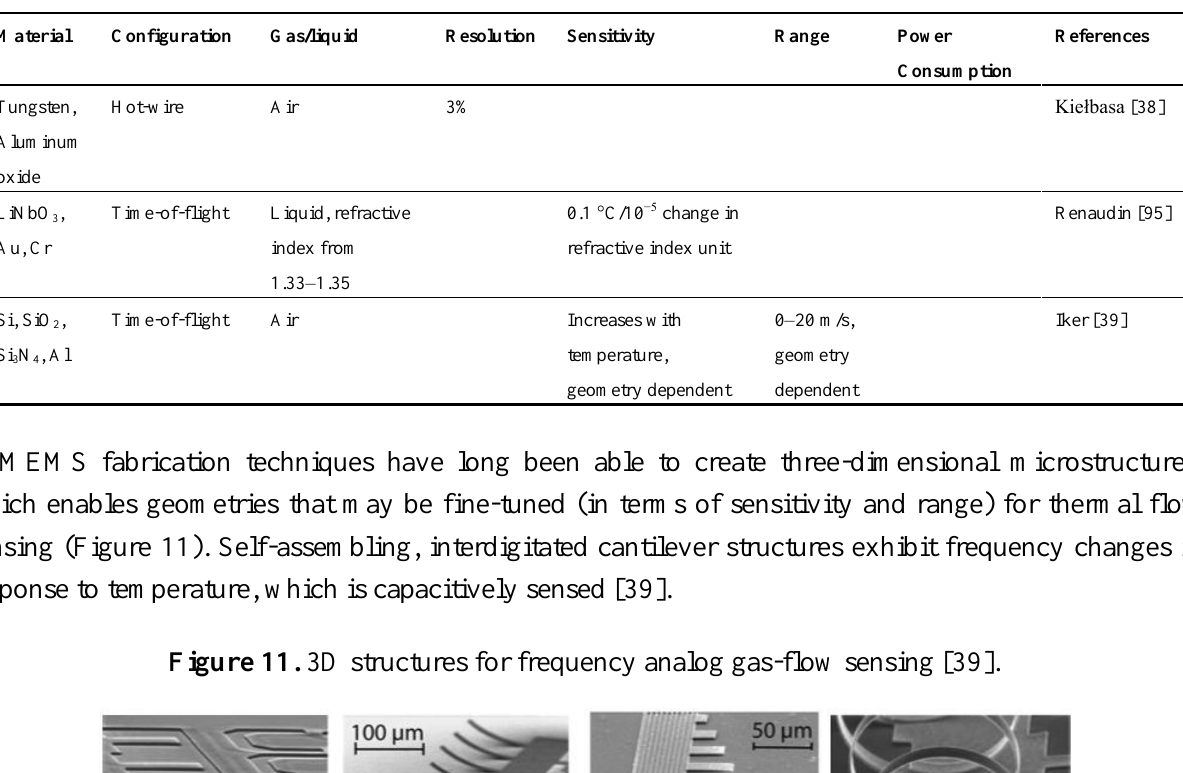
Table 6. Frequency analog flow sensor feature comparison.